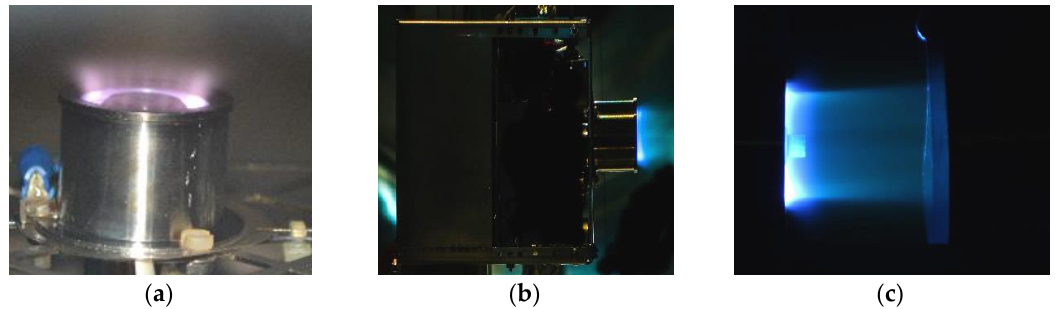
Figure 8. Cathodeless Hall Effect Microjet thruster: ( a ) close-up view on thruster operating with synthesis gas; ( b ) mounted on a 1U shell containing the thruster controller, the power processing unit (PPU), and propellant management unit (PMU), including tank and gas regulation; ( c ) the plume of the thruster when operating with Xe during ion current measurements.